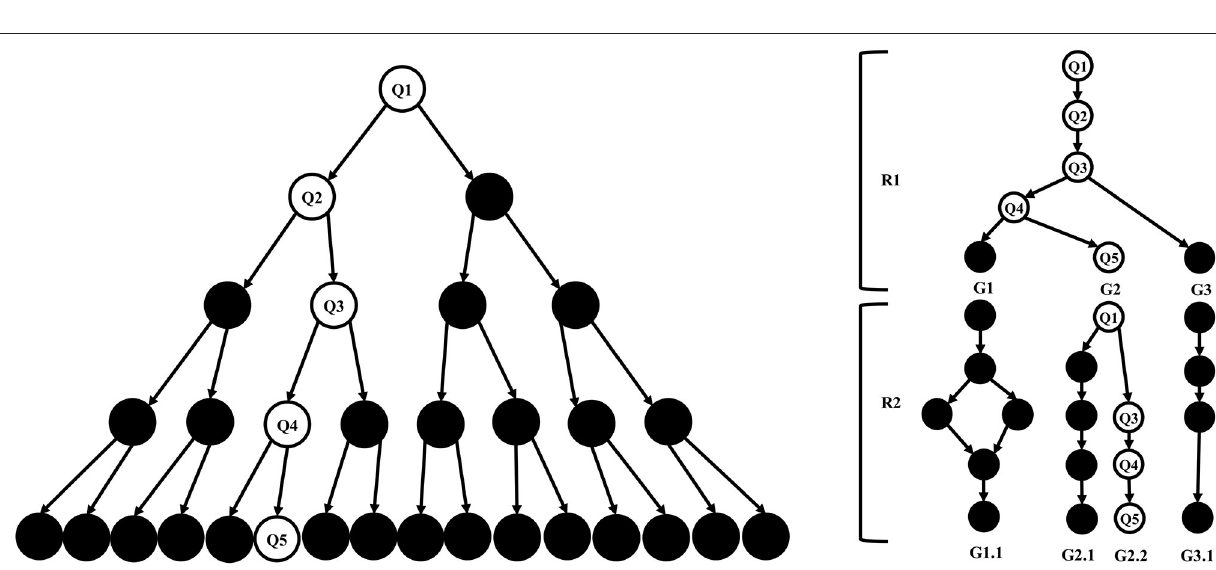
interview. Results and data visualizations for all studies can be accessed on the 5Q results dashboard 1